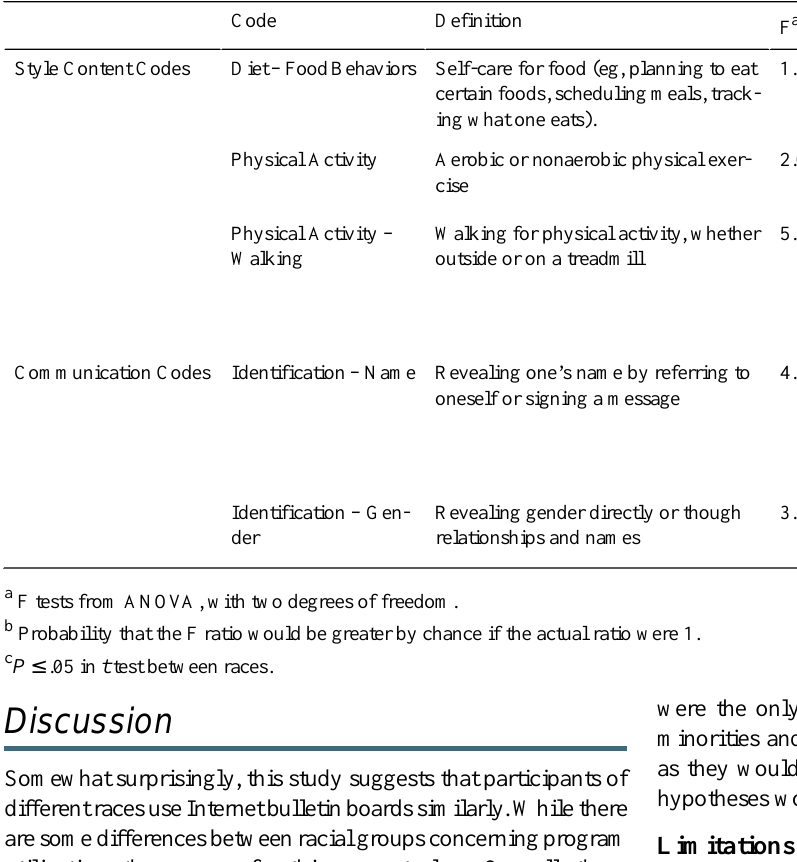
Table 3. Significant differences in mean percent of messages for all codes by